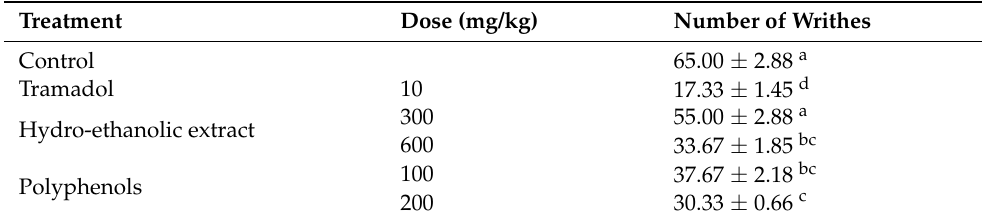
Table 3. L. officinalis Chaix extracts’ impact on the mice’s response to acetic acid-induced writhing ( n =